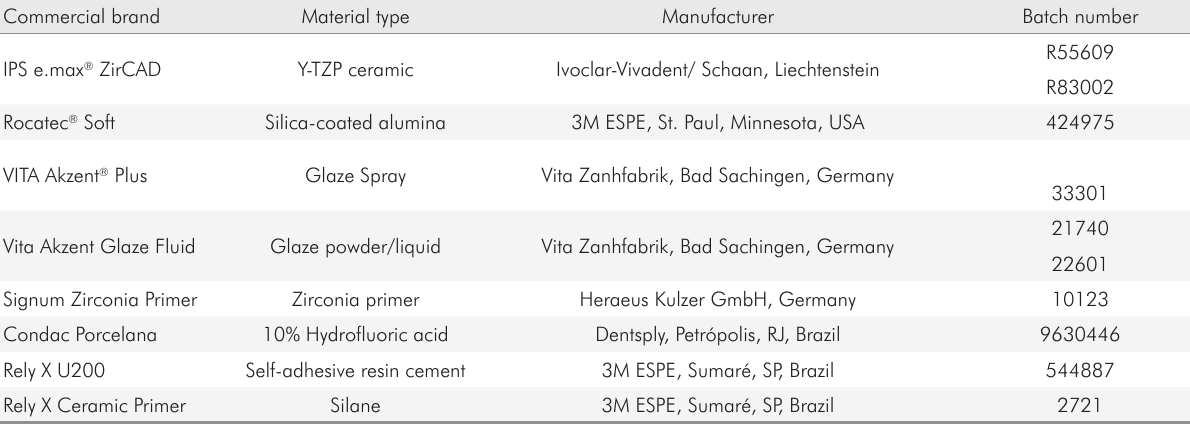
Table 1. Commercial brand, material type, manufacturer, and batch number of materials used in the research. Commercial